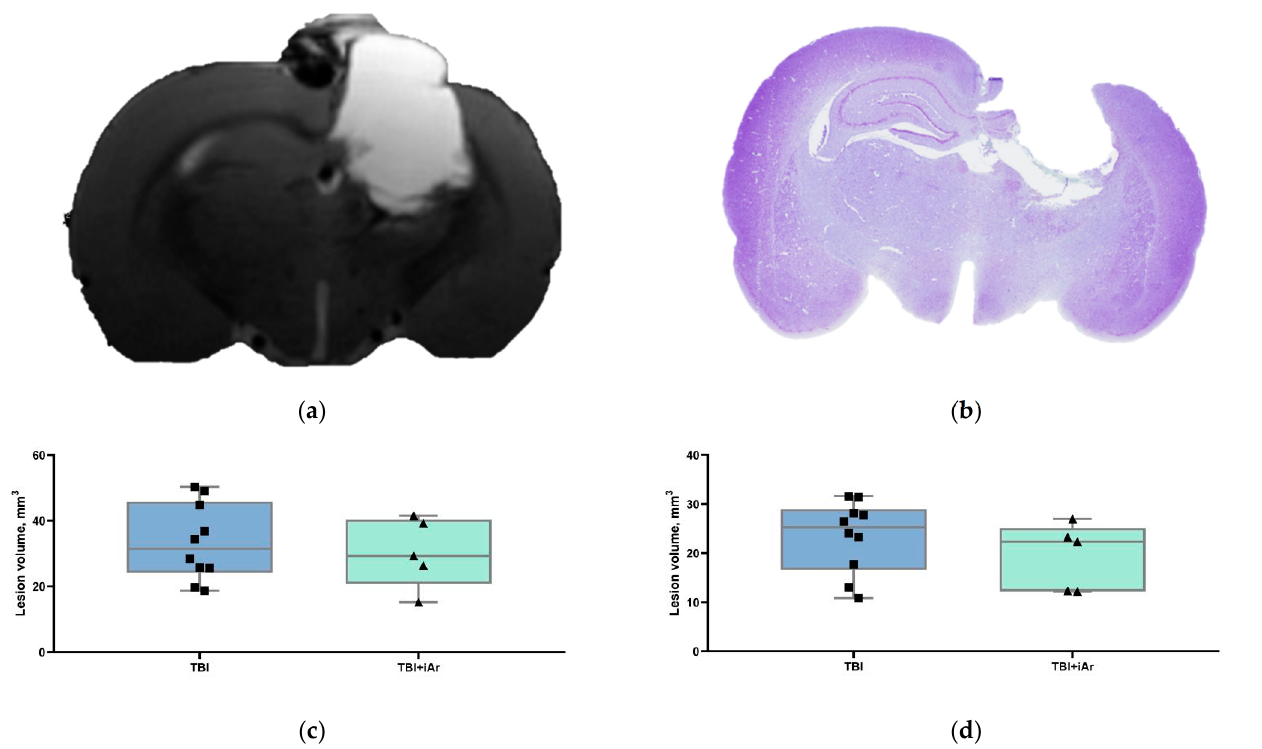
Figure 4. ( a ) Representative T2-weighted coronal MR-images and ( b ) cresyl violet-stained sections of the rat brain on day 14 post-TBI demonstrating loss of cortical tissue at the site of impact. ( c ) Volume of brain lesions caused by traumatic brain injury in the TBI and TBI + iAr groups based on MRI data. ( d ) Volume of brain lesions caused by traumatic brain injury in the TBI and TBI + iAr groups based on histological examination data. No significant difference between the groups was found (Mann–Whitney U criterion). The data are presented as median, quartiles, and single values.